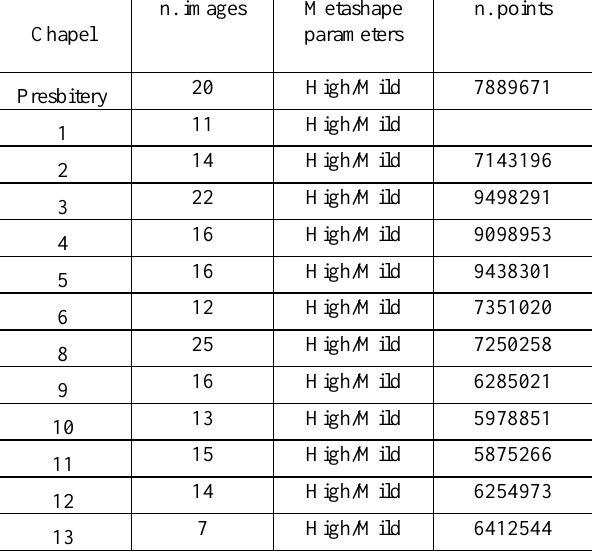
Table 1 . Parameters CRP surveies